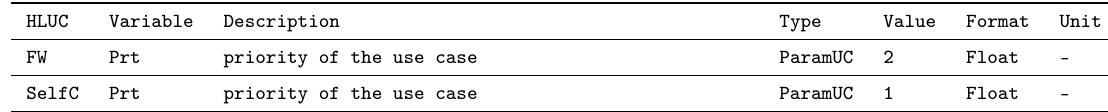
Table 18. Configuration of